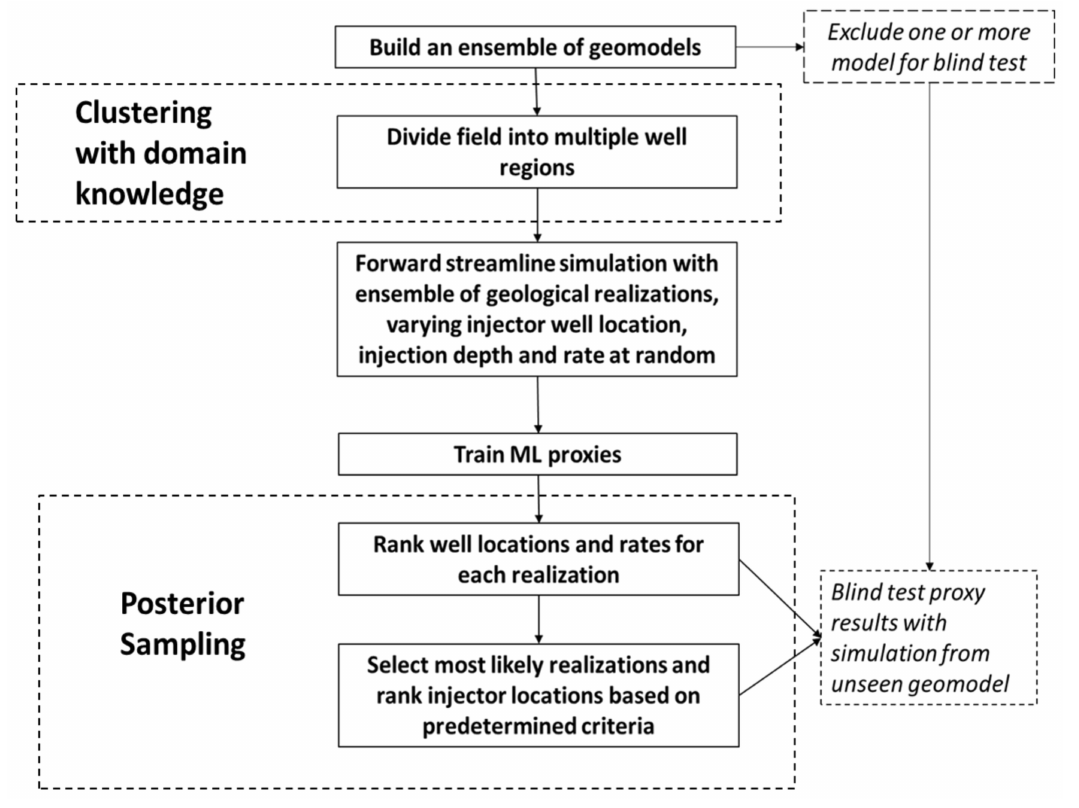
Figure 2. Overall workflow proposed. Table 1. Key parameters of the base